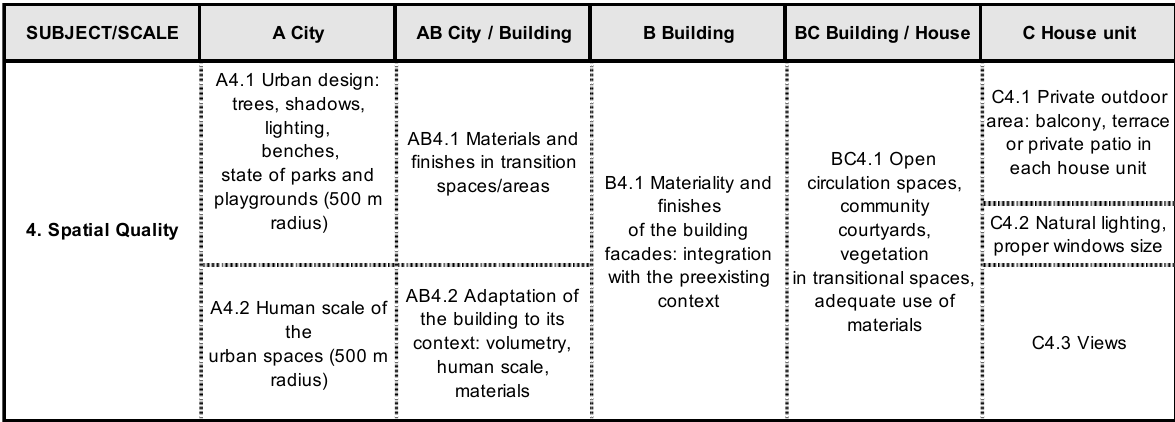
Figure 4. Spatial Quality Indicators. Source own elaboration.